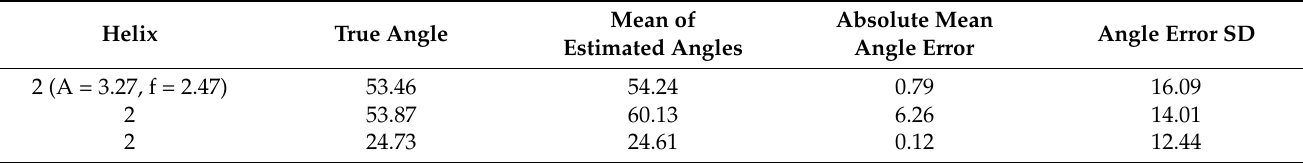
Table 3. Montecarlo scenario (3000 repetitions) on helixes modelling severe spinal deformities (larger Cobb angles) during movement. Assessed Absolute Mean Angle Error and SD simulating 3D marker-misplacement error (i.e., in all possible